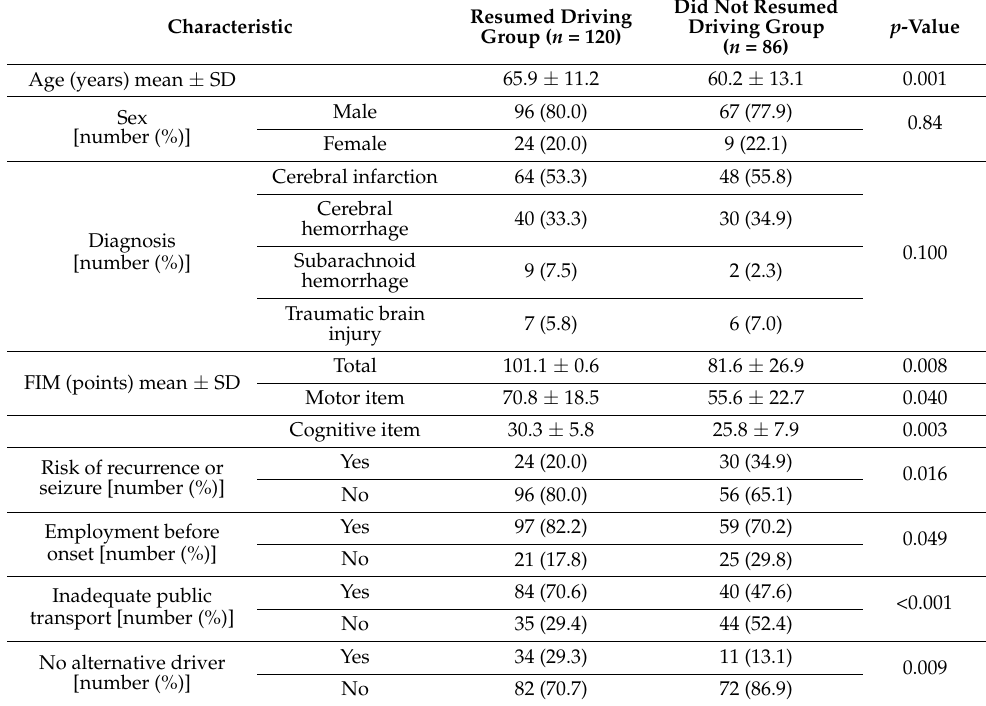
Table 1. General characteristics of the study participants and the differences in variables between the “resumed driving” group and the “did not resumed driving”